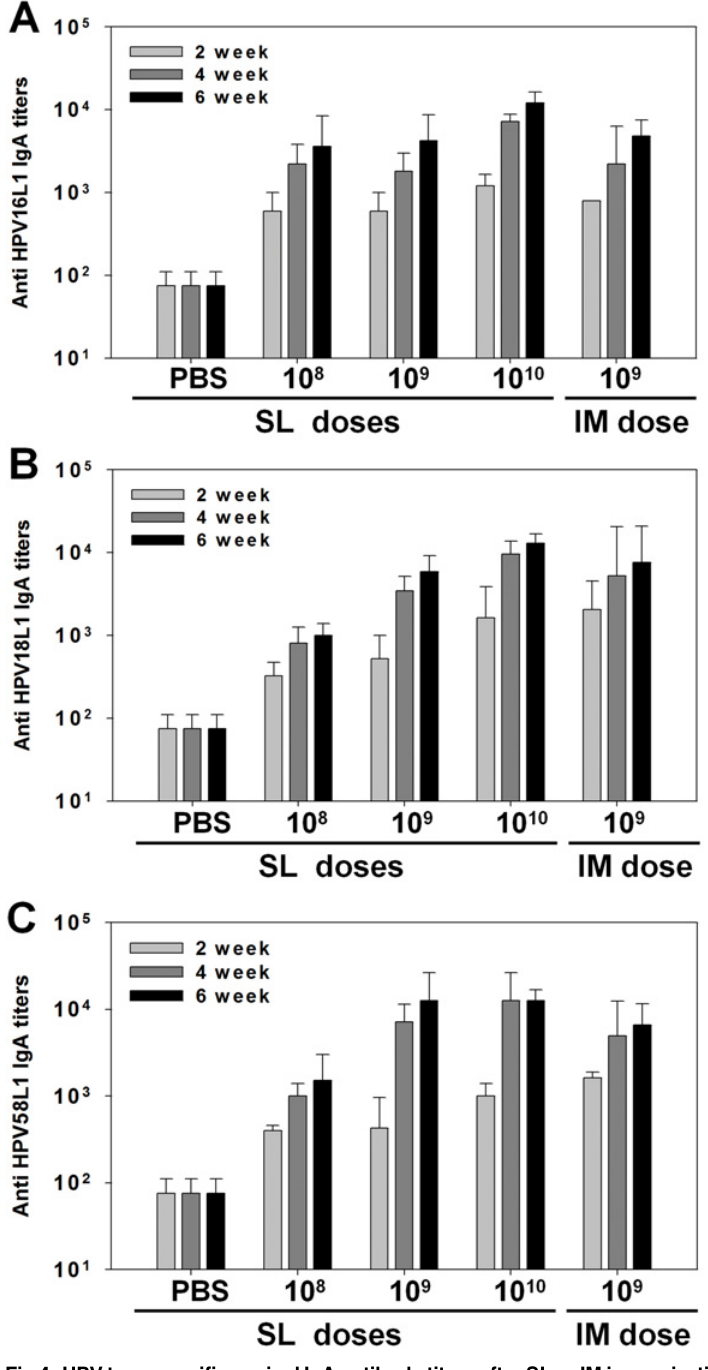
Fig 4. HPV type-specific vaginal IgA antibody titers after SL or IM immunization. Mice were administered AcHERV-triHPV or PBS (control) three times over a 2-week interval by the SL or IM route. Mice were sublingually immunized with three different doses of AcHERV-triHPV (1×10 8 , 1×10 9 , and 1×10 10 copies per mouse) or immunized intramuscularly with 1×10 9 copies per mouse. Vaginal secretion was sampled 2, 4, and 6 weeks after the first immunization. Antigen-specific vaginal IgA antibody titers against HPV16L1 (A), HPV18L1 (B), and HPV58L1 (C) were determined by ELISA. * P < 0.05 compared with other groups (ANOVA and Student-Newman-Keuls test).